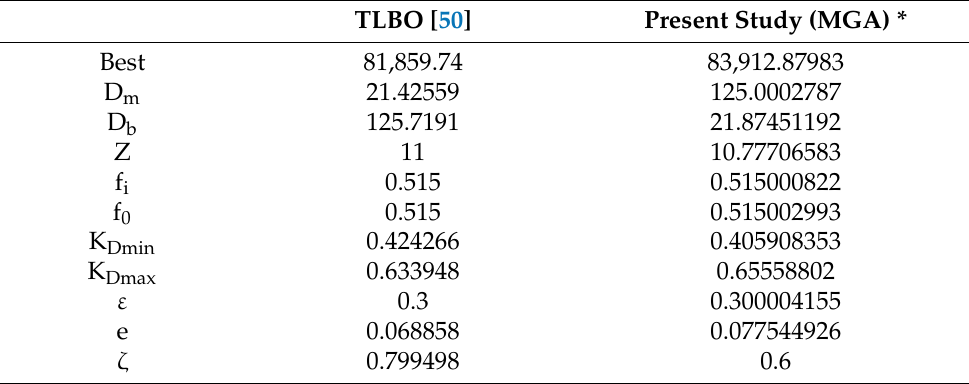
Table 21. Comparison of the best solutions for the rolling element bearing design problem.